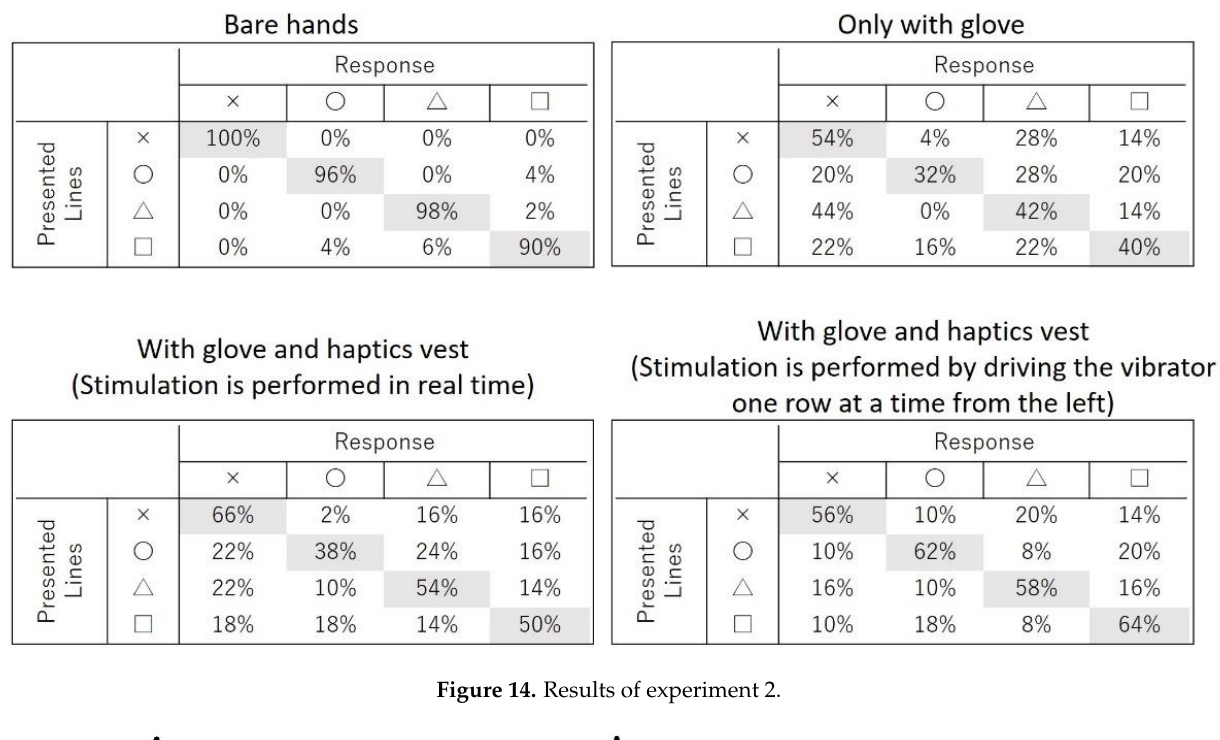
Figure 15. Identification rate of object shape under each scenario. 4.3. Discussion Compared with experiment 1, experiment 2 had a lower discrimination rate under all tactile conditions. In the scenario using the haptic vest, the identification rate was higher than that in the case of using the glove, where the stimulation is performed by driving the vibrators one row at a time from the left. Compared to the experiment 2, the objects of different shapes have many combinations of vertices and straight lines. This led